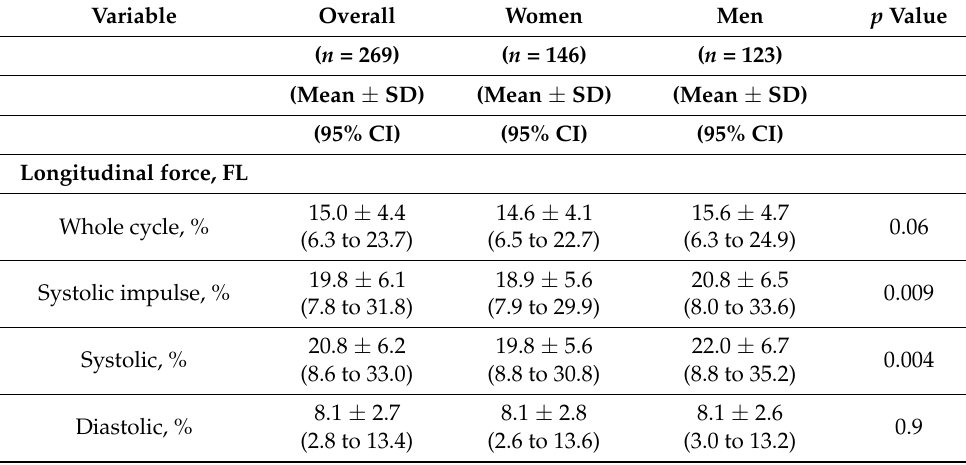
Table 5. Hemodynamic forces parameters in study